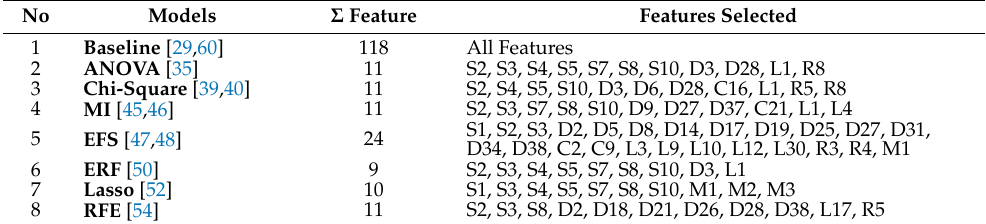
Table 2. Selected features in each method.